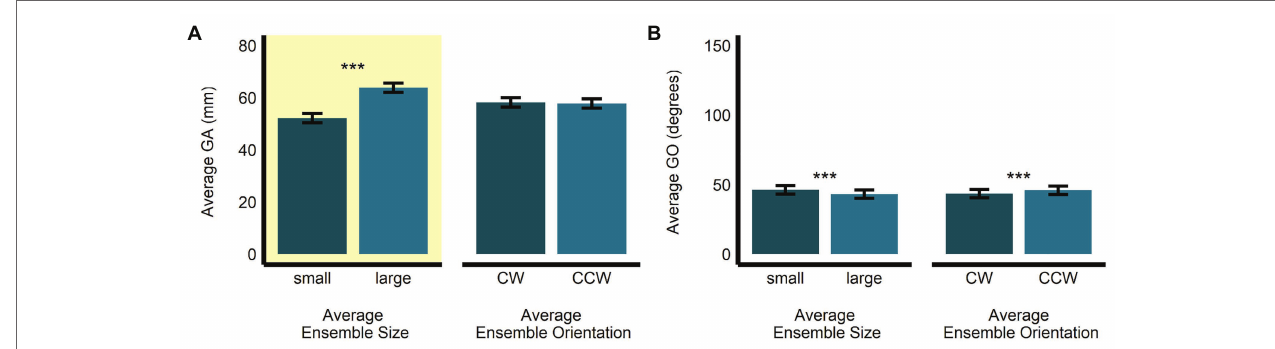
FIGURE 3 | Univariate results of the perceptual average size-discrimination task. Estimated marginal means of average (A) grip aperture and (B) grip orientation are given for the small and large average size ensemble displays, and for the CW and CCW average orientation ensemble displays. *** p < 0.0001; error bars depict SEM; GA, grip aperture; GO, grip orientation; CW, clockwise; CCW, counter-clockwise. Grip aperture was the grasp parameter most relevant to the size- discrimination task and is highlighted in yellow.